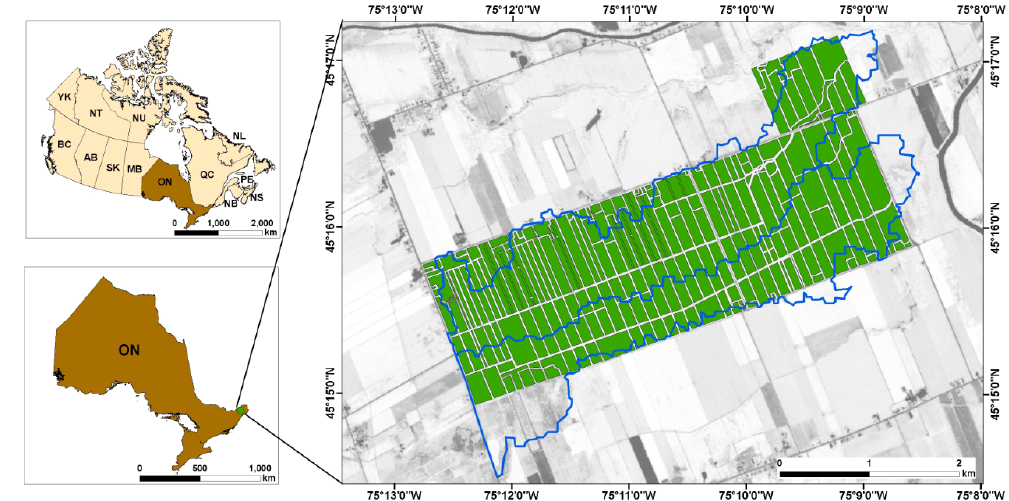
Figure 1. Overview of the study area. The fields (green polygons) located within the experimental micro watershed (blue outline). The background image is a RapidEye NDVI image. Not all fields were used within this analysis. The study area is located within the province of Ontario (Brown polygon, lower left ), within Canada ( upper left panel ).